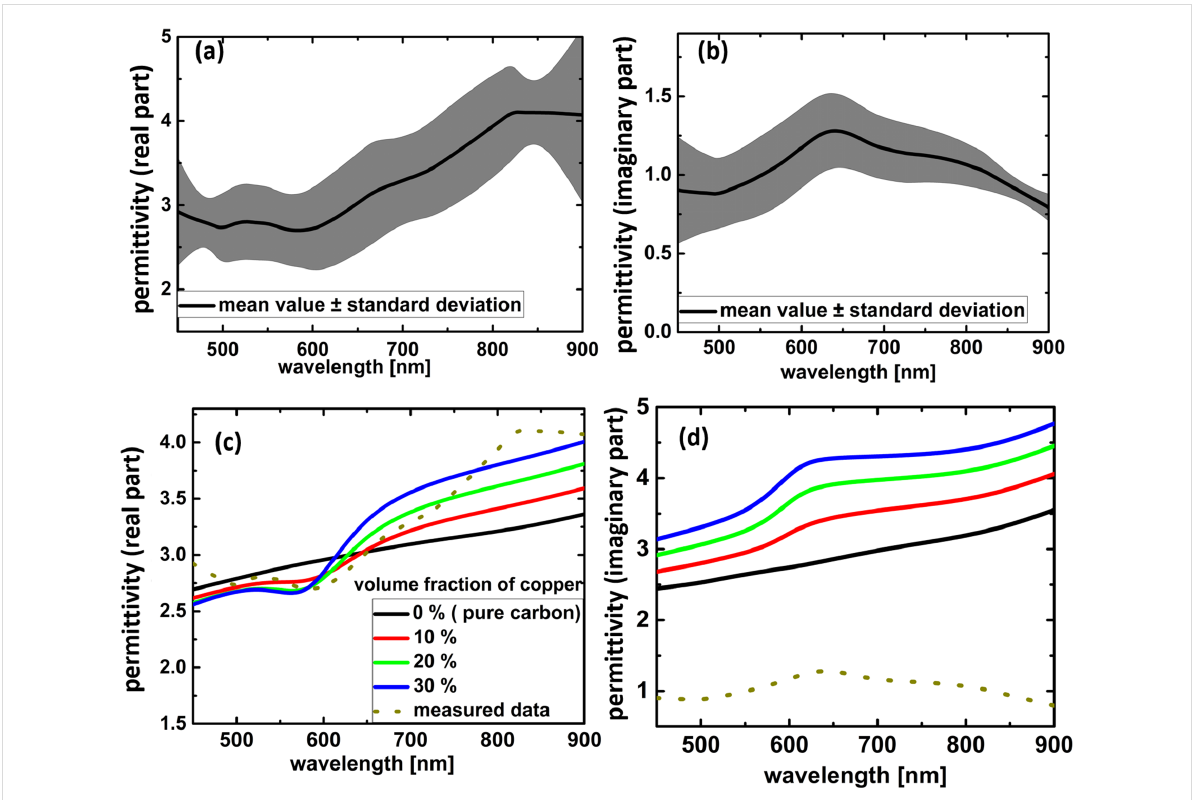
Figure 3: (a) Real and (b) imaginary part of the dielectric function of the measured FEBID material, averaged over 5 pads together with the standard deviation. (c) Real and (d) imaginary part of the Maxwell–Garnett model. The model uses the dielectric function of copper from [24], and of carbon from [23]. The dotted lines are the measured